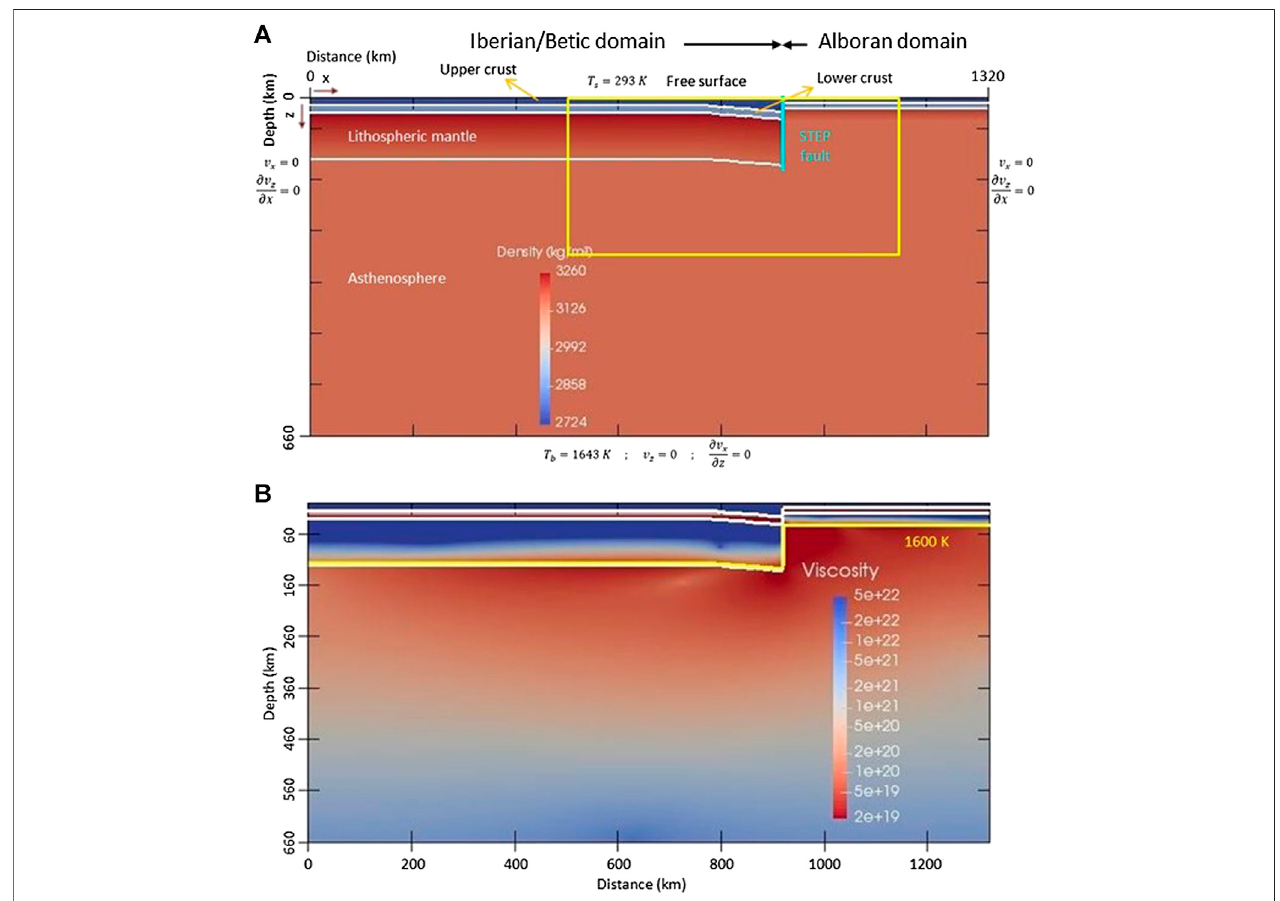
FIGURE 4 | Model setup for the Reference Model with the (A) initial density distribution and boundary conditions. The contour of the Iberian mantle lithosphere is shown for better understanding the evolution of delamination, albeit having the same composition and parameters as the asthenosphere and Alboran lithospheric mantle. (B) Initial viscosity distribution (units Pa s) and 1,600 K isotherm to show the initial lithospheric thickness.